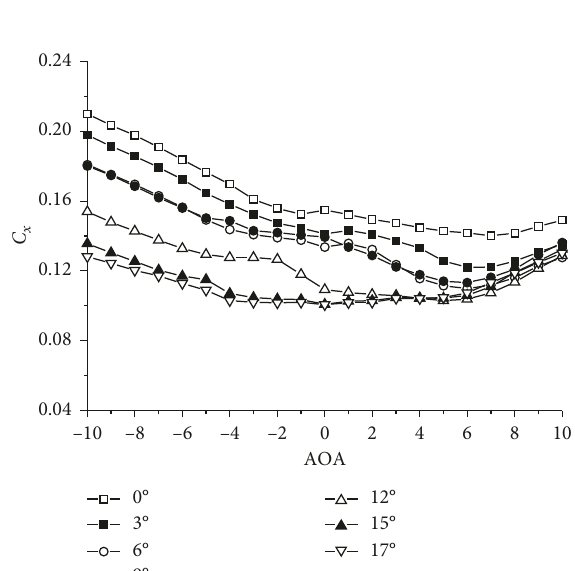
Figure 9: AOA controller and protractor.